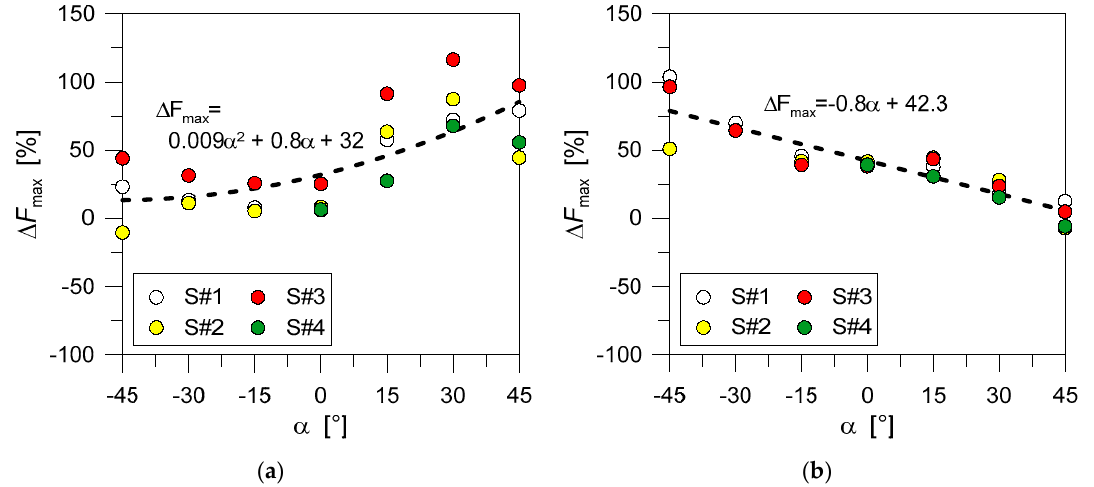
Figure 13. Percentage scatter of maximum force values for TTC joints with inclined STSs (Equation (5)),